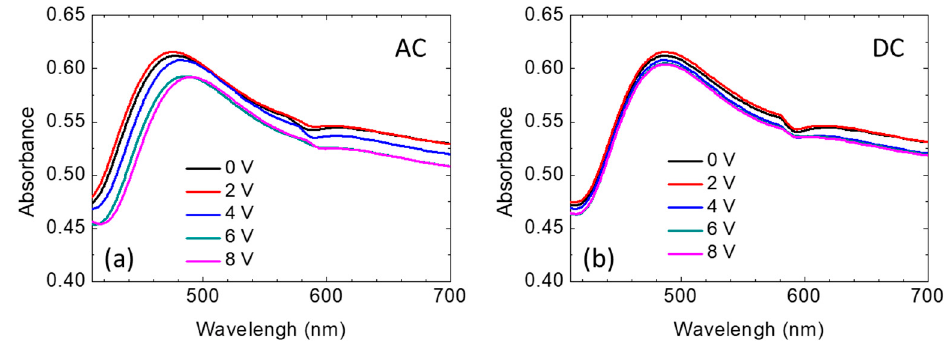
Figure 4. Nonpolarized spectra of the liquid crystal (LC) / gold nanoisland film (Au NIF) with applied voltages of amplitudes 0~8 V under ( a ) Alternating current (AC) and ( b ) Direct current (DC) voltage.